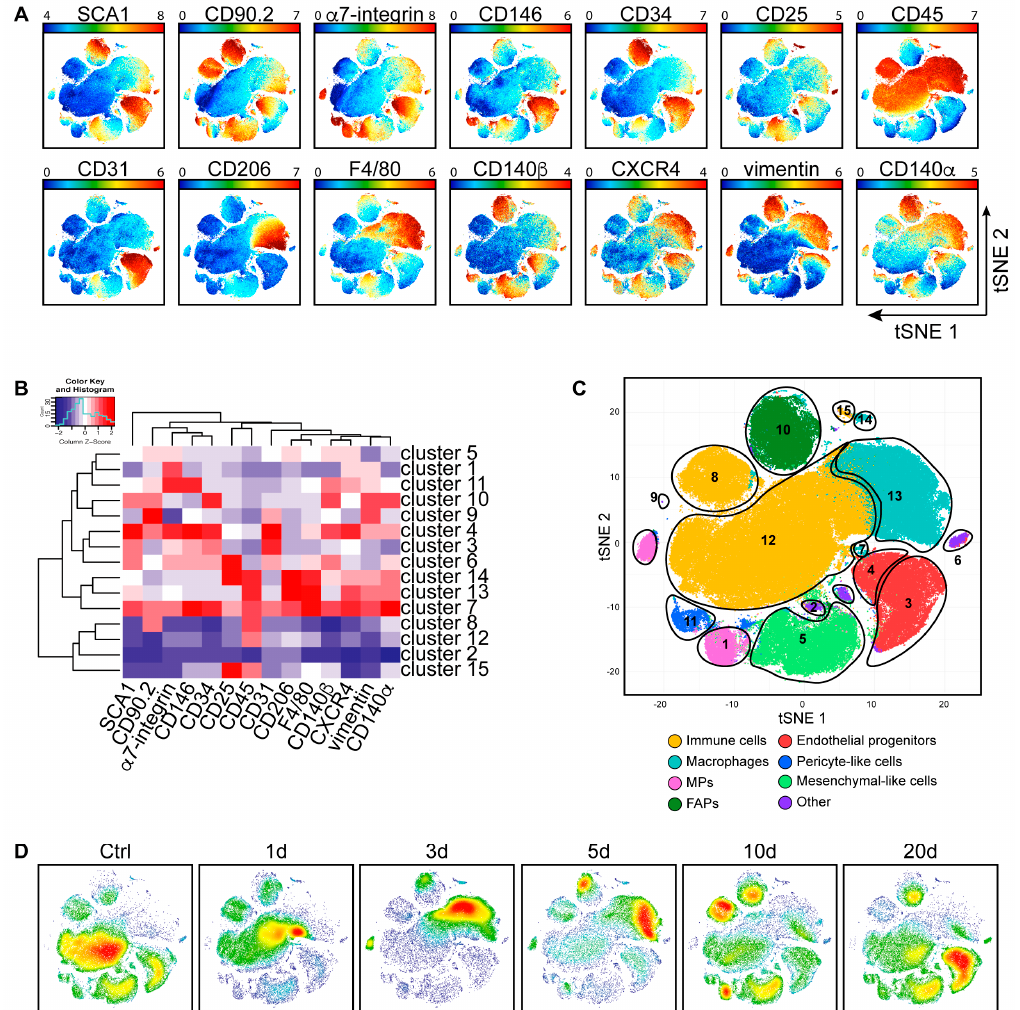
Figure 2. Dynamic changes of mononuclear cell subpopulations in wt muscles during regeneration. ( A ) The different mononuclear cell samples from uninjured and CTX-injured wt hind limb muscles were merged to create a single t-distributed stochastic neighbor embedding (t-SNE) map; colored according to expression levels of SCA1, CD90.2, α 7-integrin, CD146, CD34, CD25, CD45, CD31, CD206, F4/80, CD140 β, CXCR4, vimentin, and CD140 α (blue: low expression; red: high expression of the selected marker). ( B ) FlowSOM heatmap of column normalized (Z-score) marker expression for each of the 15 identified clusters. Colors varied according to the expression level of the considered marker in a blue to red scale, indicating low to high expression, respectively. ( C ) Cell clusters defined by the FlowSOM analysis were assigned to arbitrary colors (yellow: immune cells; light blue: macrophages; pink: myogenic progenitors (MPs); dark green: fibro / adipogenic progenitors (FAPs); red: endothelial progenitors; blue: pericyte-like cells; light green: mesenchymal-like cells; purple: other). ( D ) Time course of the variation in cell subpopulation abundance upon CTX-induced injury. The dynamic changes were illustrated by density plots, colored according to cell density (blue: low density; red: high